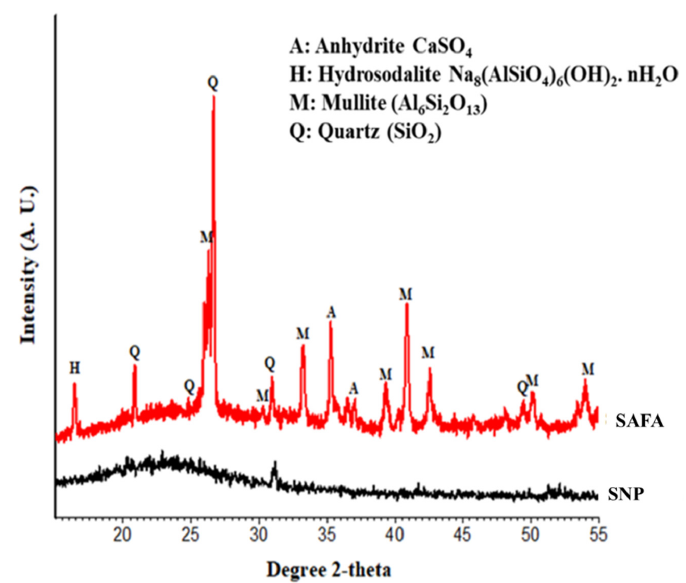
Figure 2. XRD analysis of SAFA and SNP.